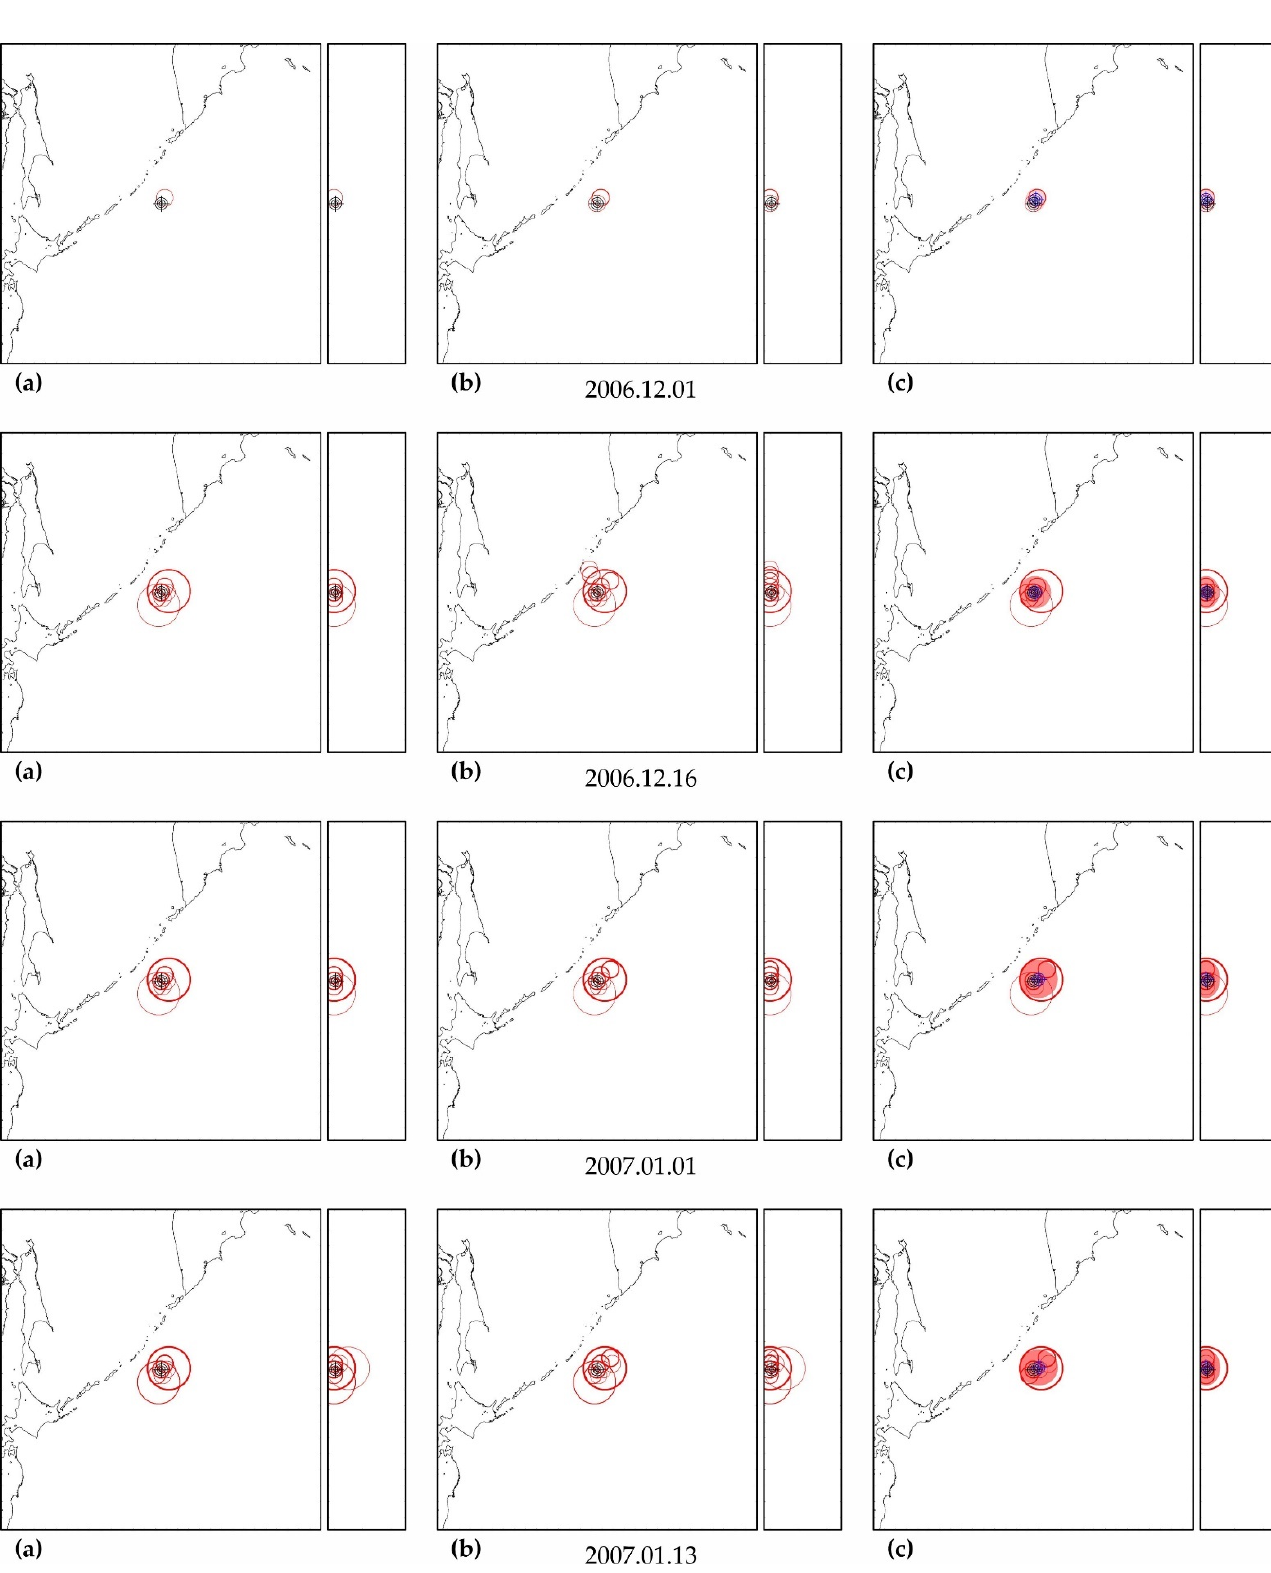
Figure A5. Zones of factual predictability for the earthquake of 13 January 2007 ( a ), identified zones with similar development according to the parameters of the DSDNP equation ( b ) and a cluster of zones of the greatest activity ( c ) used to calculate the time and place of a precedent earthquake (see Figure A3 for explanations).